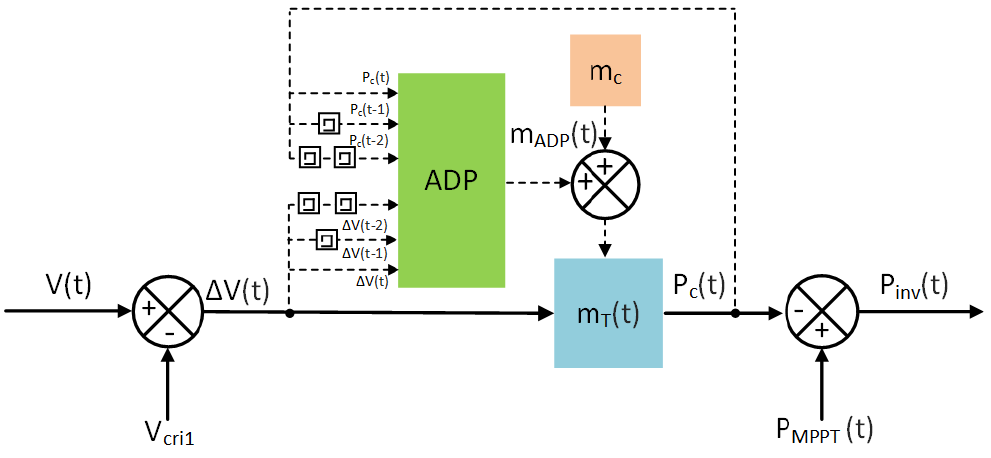
Figure 3. Adaptive dynamic programming (ADP) controller for adaptive droop control with droop- based APC technique.